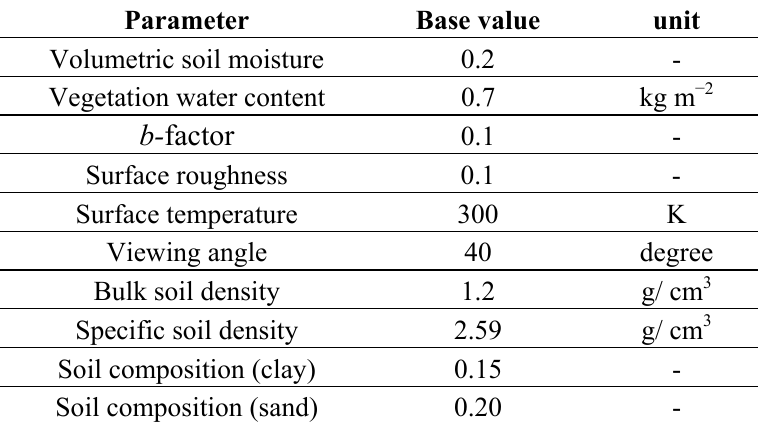
Table 3. Base values of